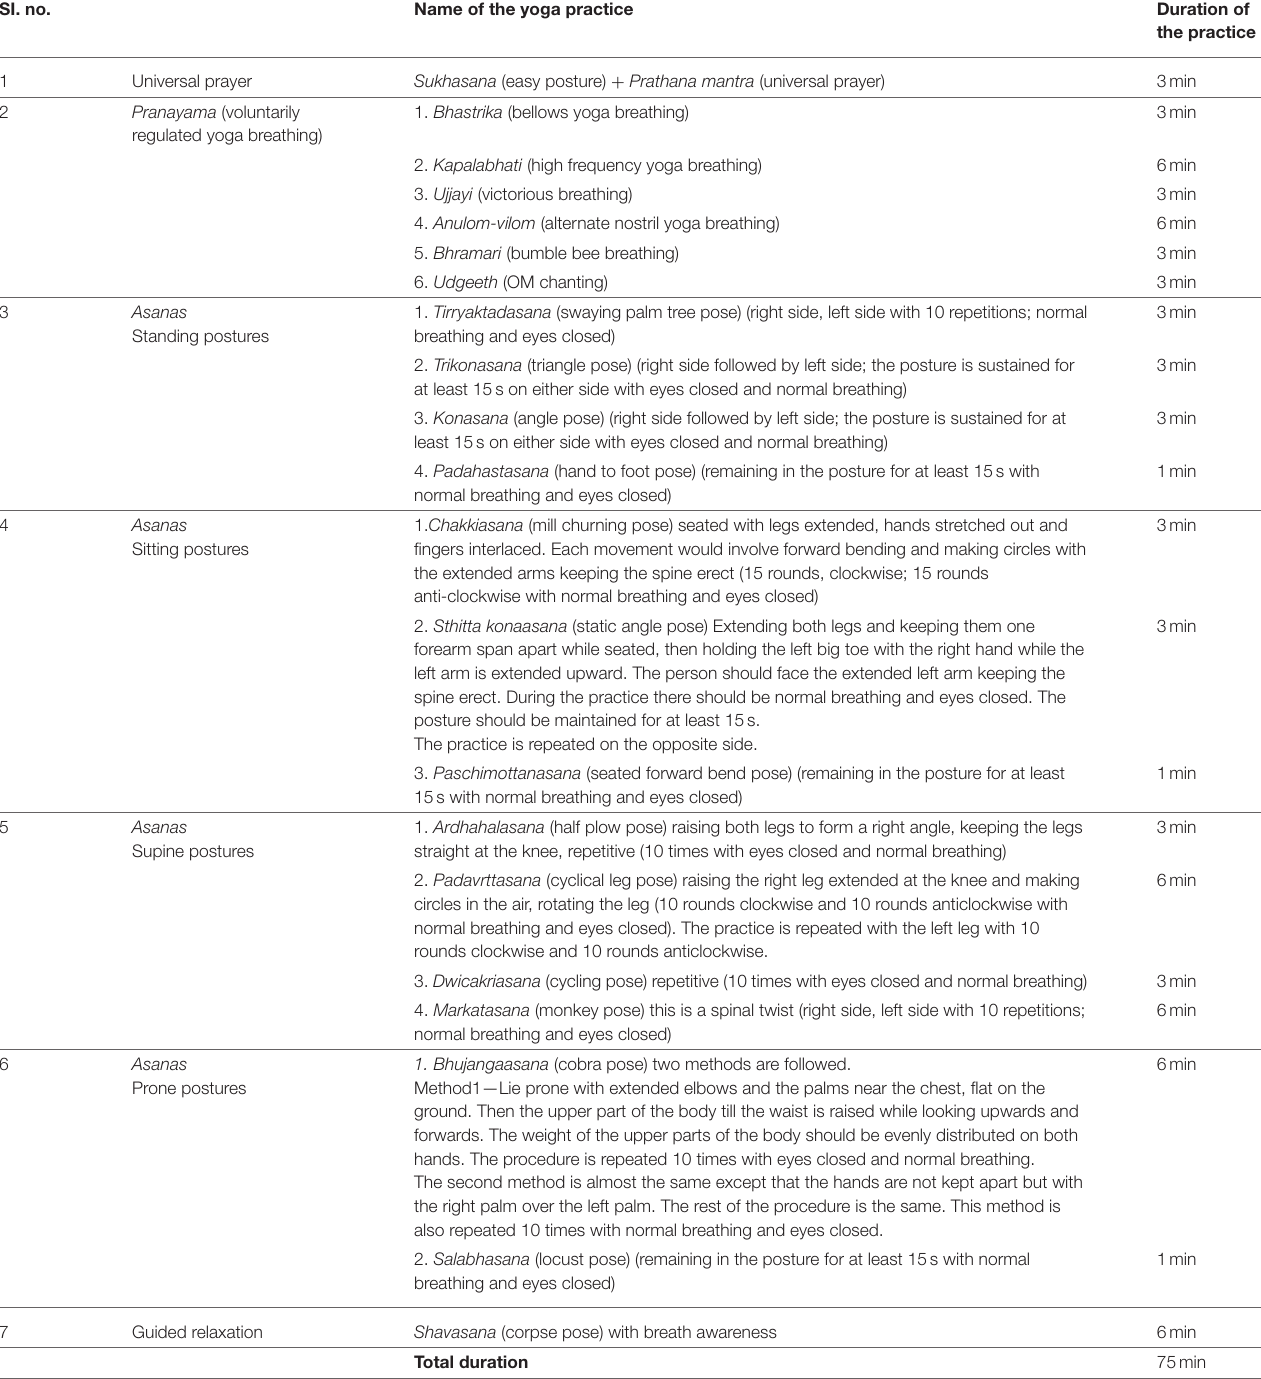
TABLE 2 | Details of the yoga intervention. SI.